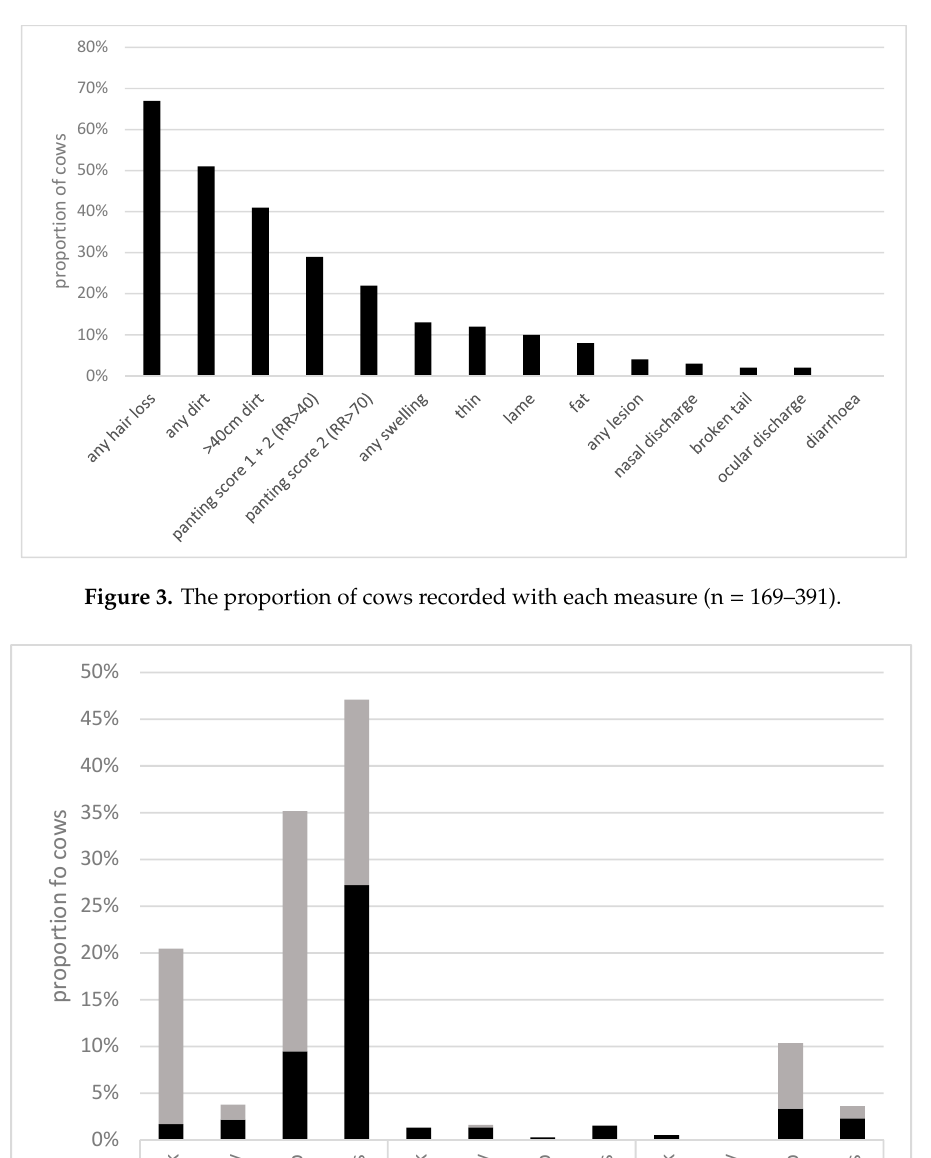
Figure 4. The proportion of cows recorded with hair loss, lesions and swellings in different body regions.